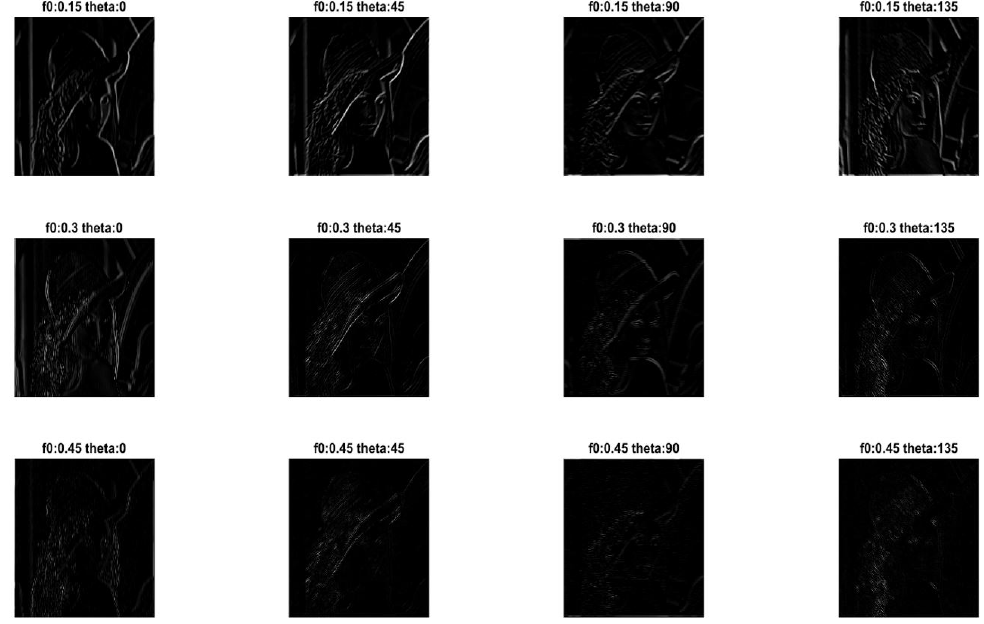
Figure 4. Edge information in particular directions and scales for Lena